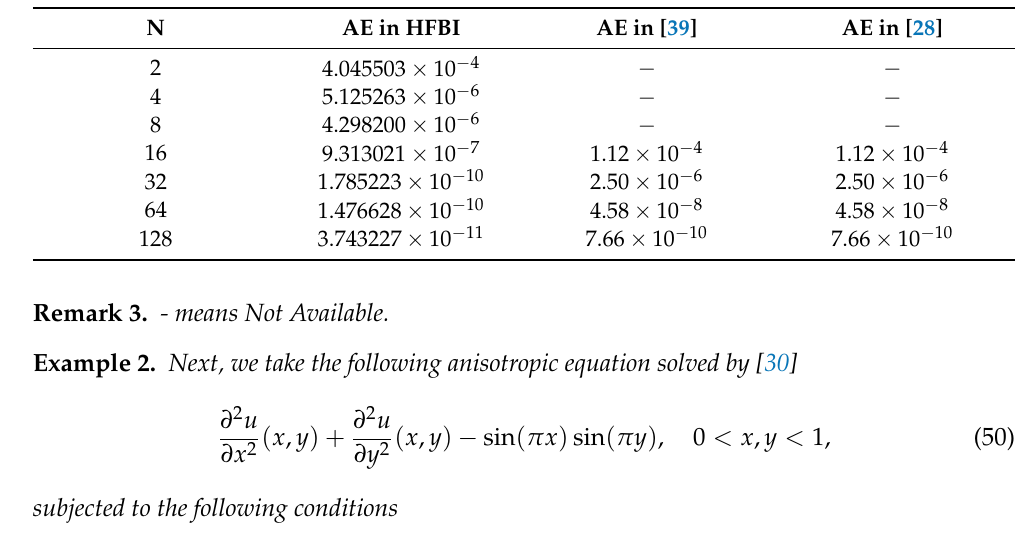
Table 3. Comparison of AE in HFBI with [39] and AE in [28] for Problem